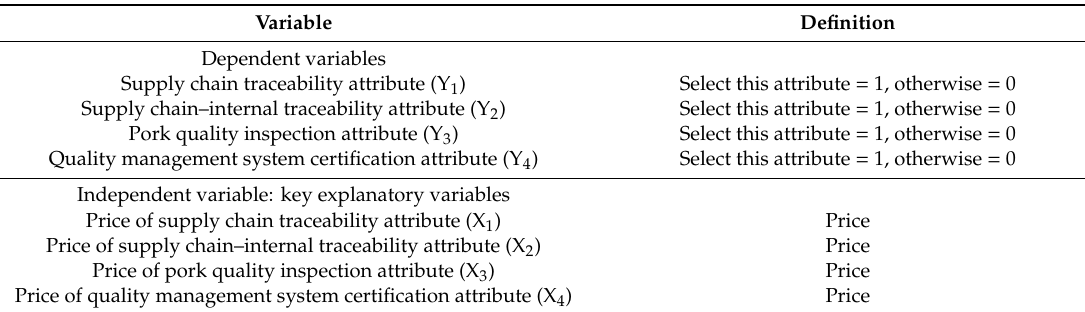
Table 5. Settings and definitions of the